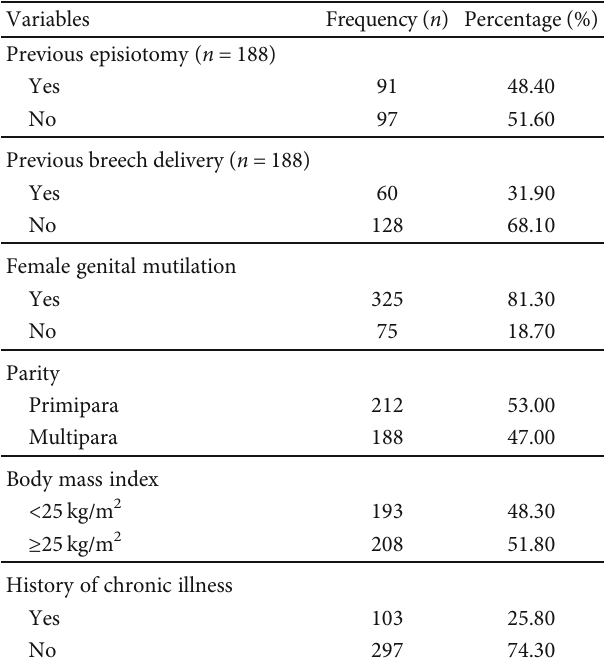
Table 3: Maternal-related characteristics of the study on magnitude and associated factors of episiotomy in Arba Minch General Hospital, Southern Ethiopia, 2019.